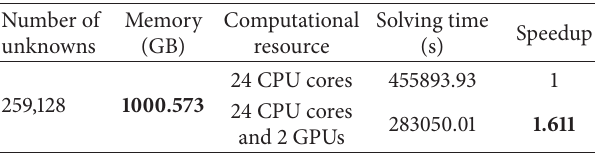
Table 2: Computational parameters for the array installed on an